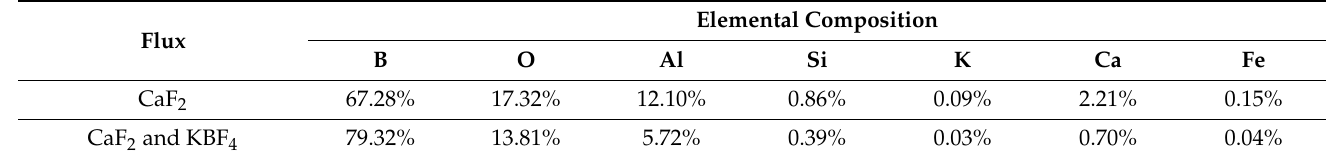
Table 6. Elemental composition of the alloy with various flux additives.